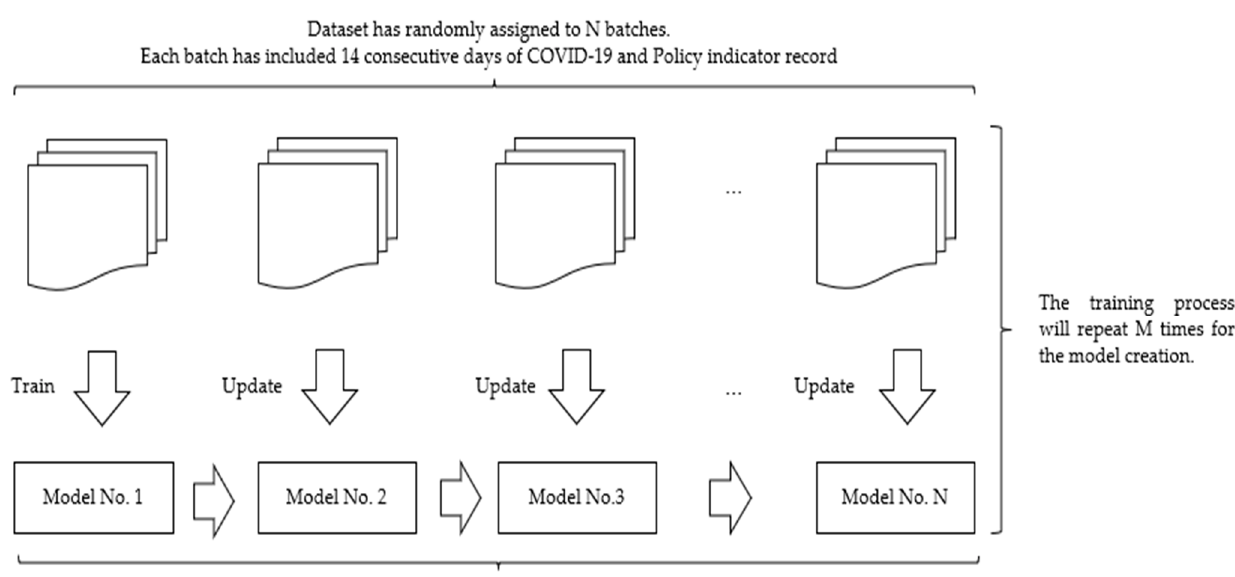
Figure 3. Incremental batch learning method for COVID-19 infection simulation model. Each batch included 14 consecutive days of records. The first batch of data was used to train model 1, while subsequent batches were used to update model parameters.